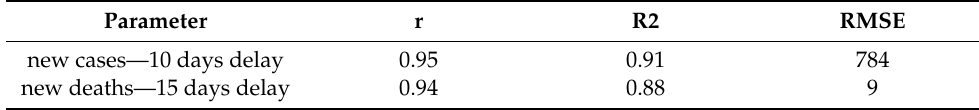
Table 2. Details of random forest